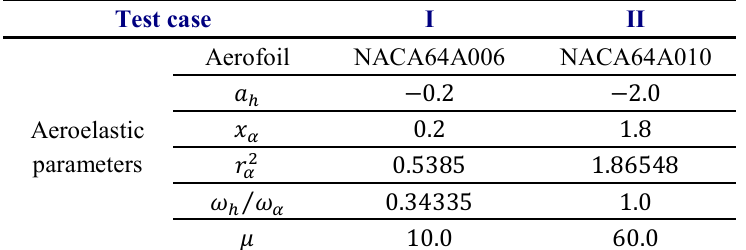
Table 2. Aeroelastic test cases for rigid aerofoil